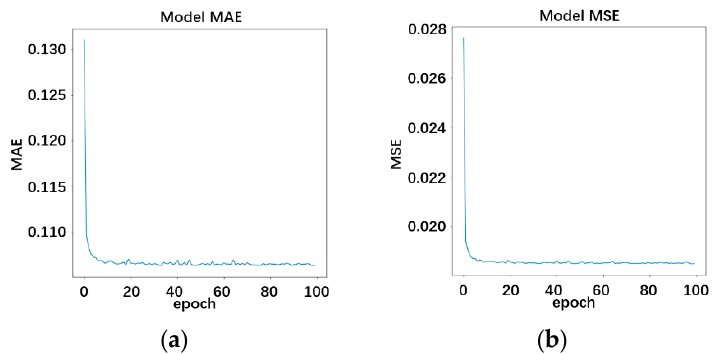
Figure 9. Model error of 2 h simulation data as training data: ( a ) model MAE; ( b ) model MSE.